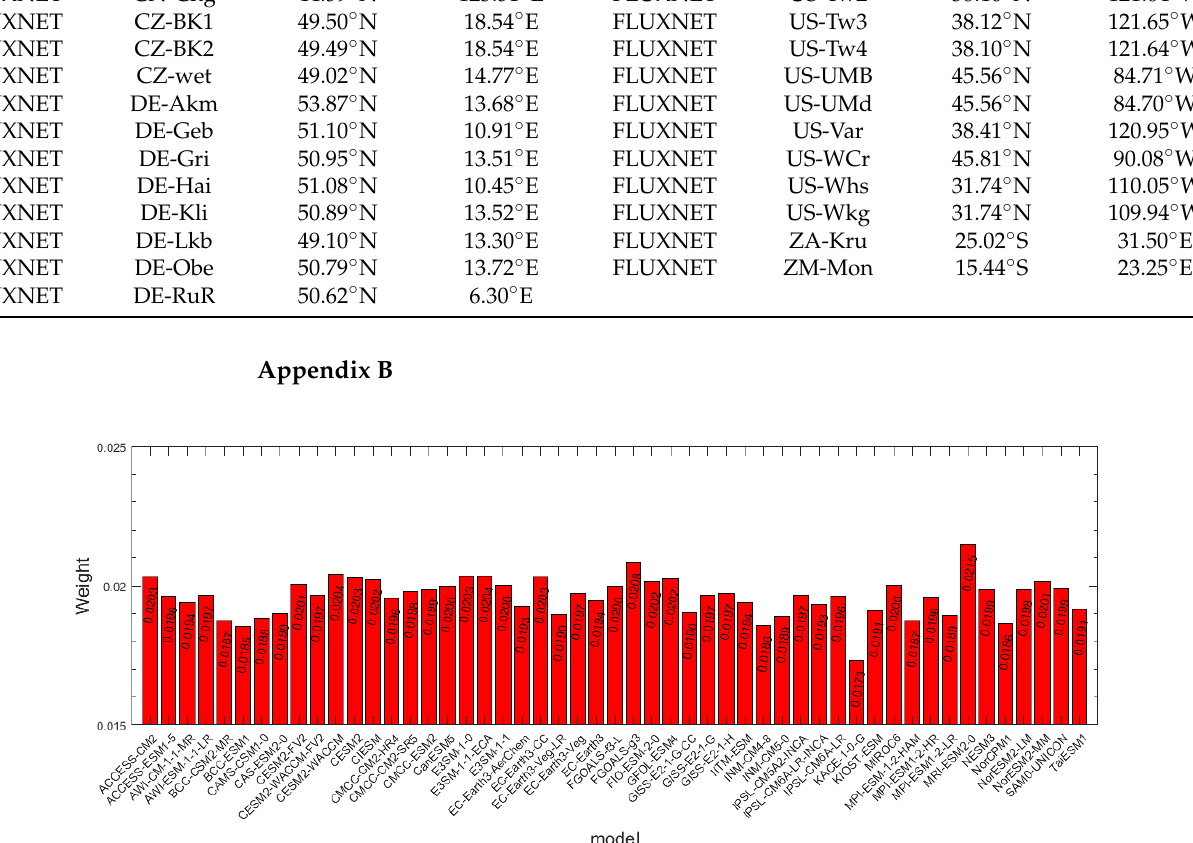
Figure A1. Relative weights of the 51 CMIP6 GCMs acquired by the Bayesian model averaging (BMA) method.